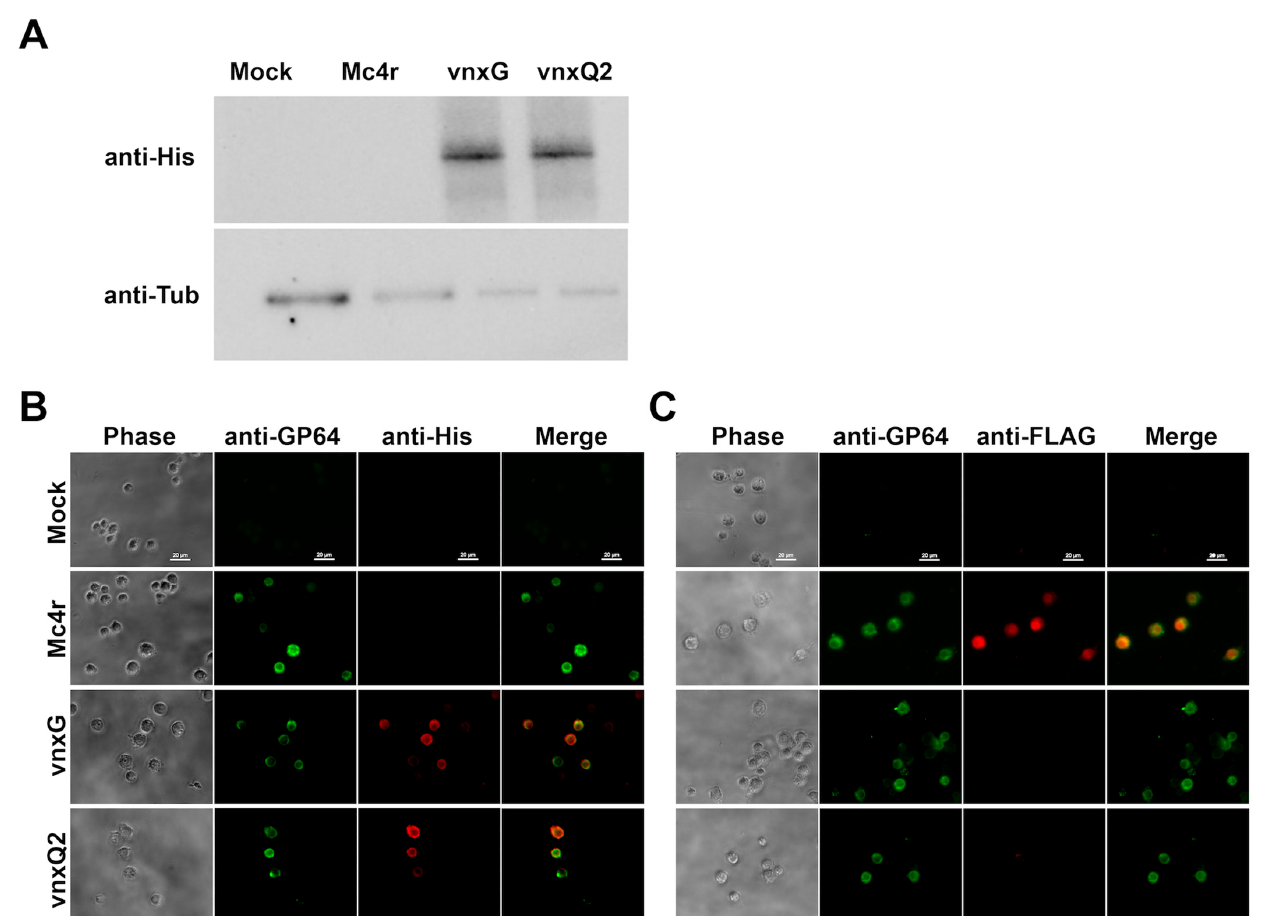
Figure 1. Vinnexins are expressed by recombinant baculoviruses in larval H. virescens hemocytes. Newly molted 4th instar larvae were injected with 100 pfu recombinant baculoviruses or media and hemocytes isolated 3 dpi. ( A ) Expression of His-tagged vinnexin was verified with anti-His western blot. Mock: mock treated; Mc4r: AcMNPV-FLAG- m c4r; VnxG: AcMNPV- vnxG -His; VnxQ2: AcMNPV- vnxQ2 -His. Bottom panel is anti-tubulin as loading control. ( B ) Anti-His and anti- GP64 immunomicroscopy was performed to verify Vinnexin expression and AcMNPV infection, respectively. ( C ) Anti-FLAG and Anti-GP64 immunomicroscopy was performed to verify FLAG-Mc4r expression and AcMNPV